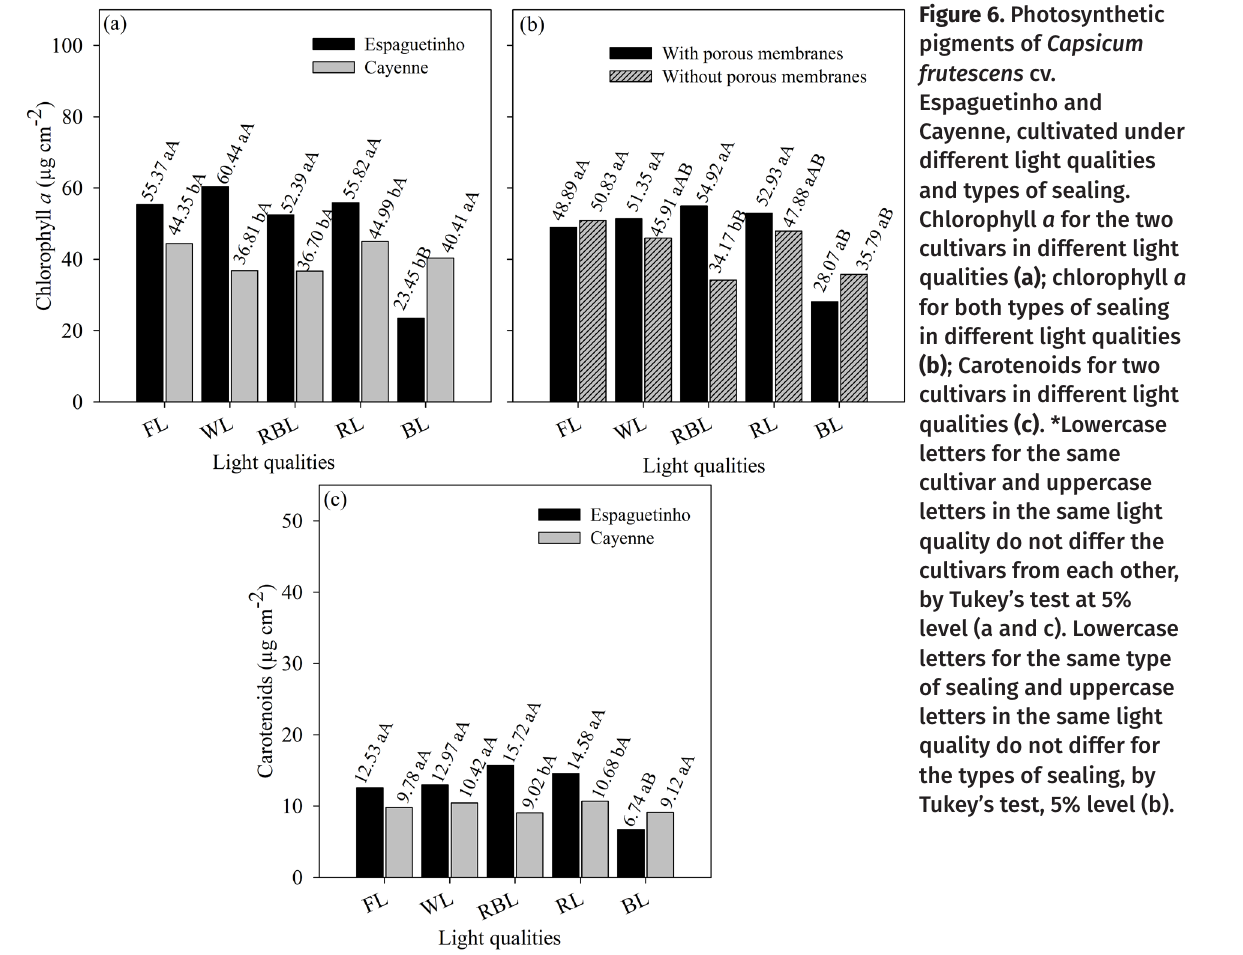
Figure 6. Photosynthetic pigments of Capsicum frutescens cv. Espaguetinho and Cayenne, cultivated under different light qualities and types of sealing. cultivars in different